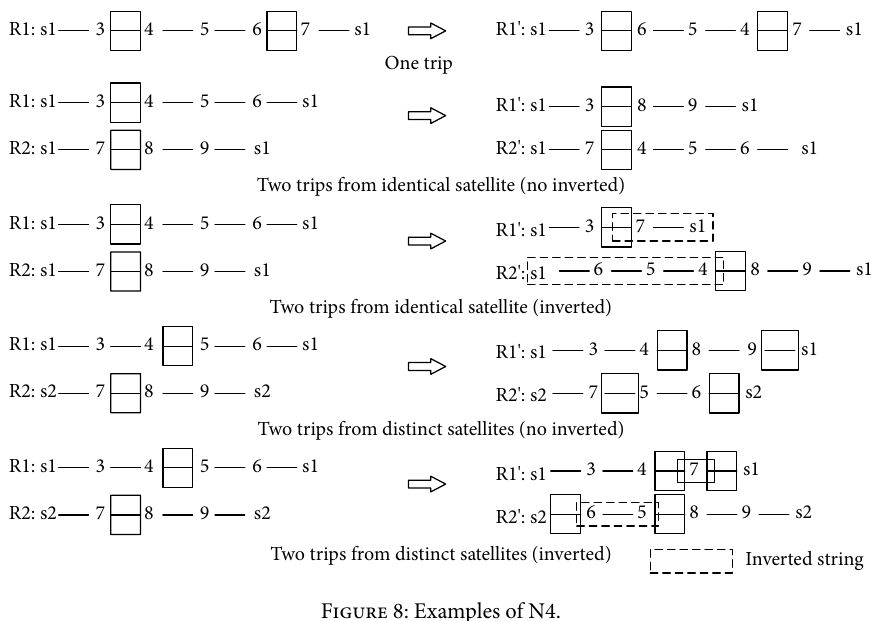
Figure 8: Examples of